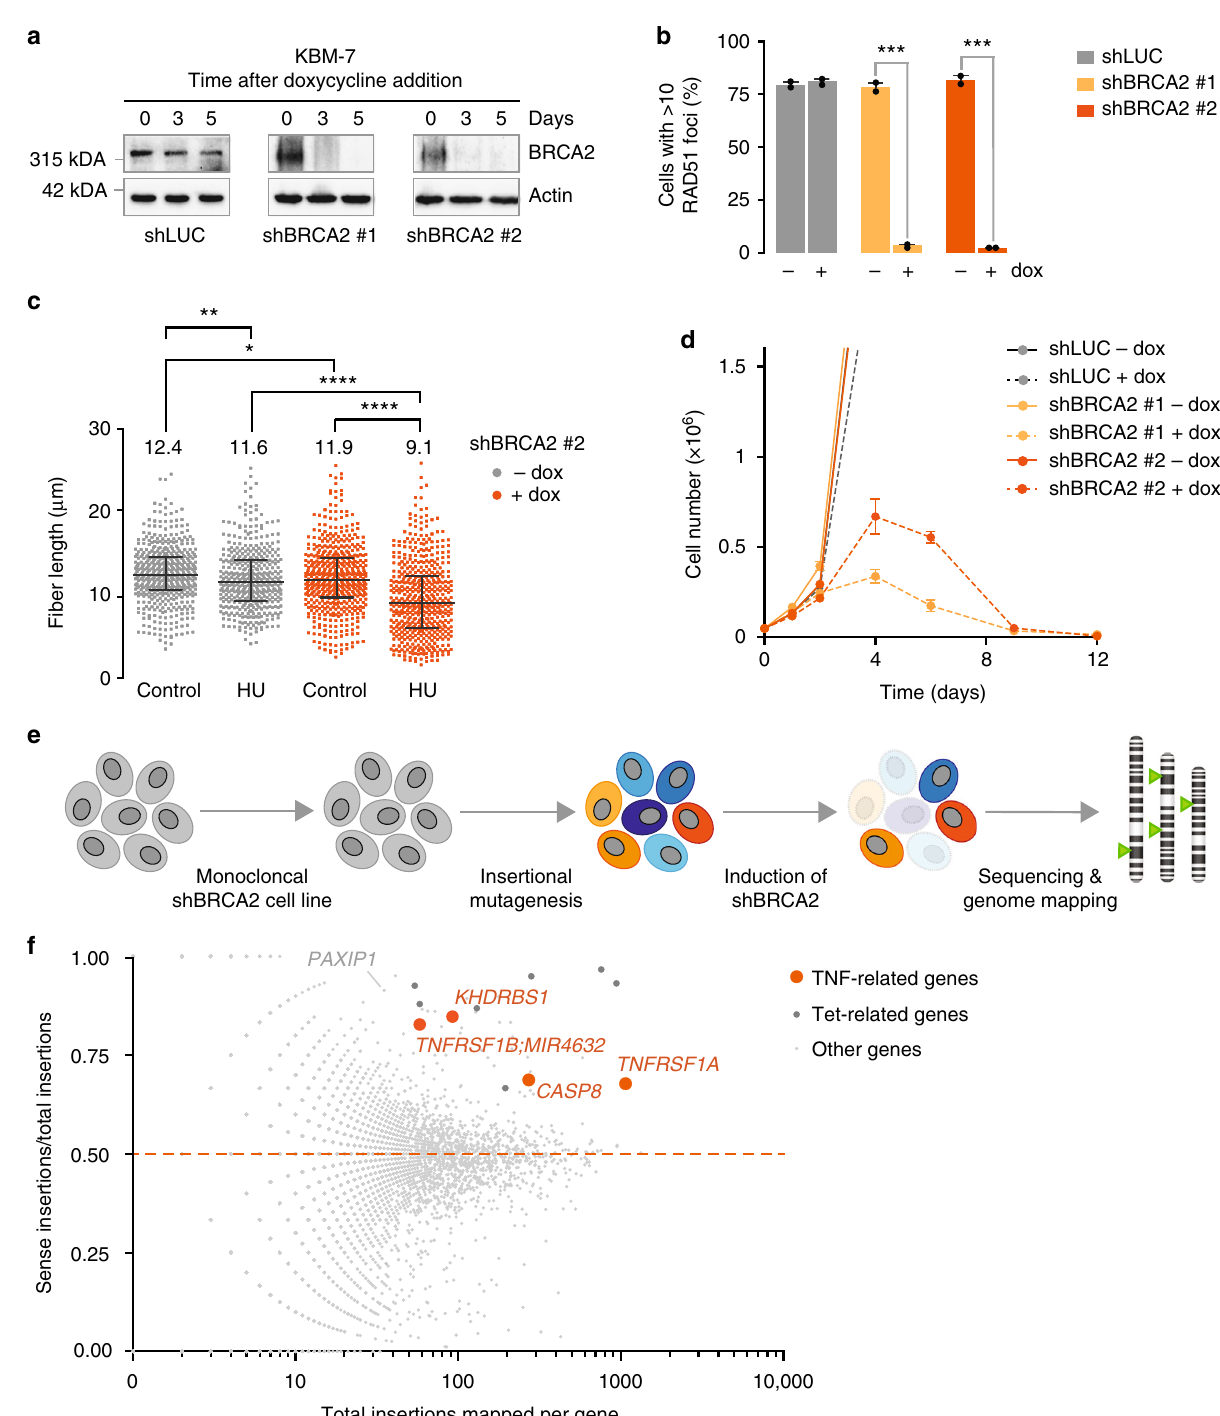
TNF α signaling determines viability in BRCA2-depleted cells . To assess whether BRCA2 mutations in cancers are associated with decreased expression of identi fi ed genes, we analyzed the serous ovarian cancers (SOC) within The Cancer Genome Atlas (TCGA) dataset 32 . We speci fi cally analyzed SOC, since BRCA2 germline mutations are most frequently found within this sub- group of ovarian cancers. Interestingly, the TNF α pathway component KHDRBS1 on average showed lower median mes- senger RNA (mRNA) levels in BRCA2 -mutated vs. BRCA2 wildtype (wt) tumors (Supplementary Fig. 1c). KHDRBS1